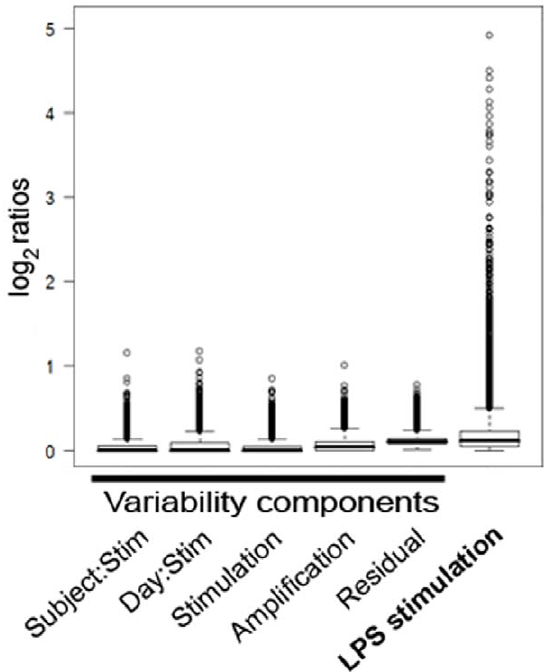
Figure 6. Standard deviations of the different variability components and gene expression values after LPS stimulation on the same log 2 scale, showing median standard deviation, interquartile ranges and